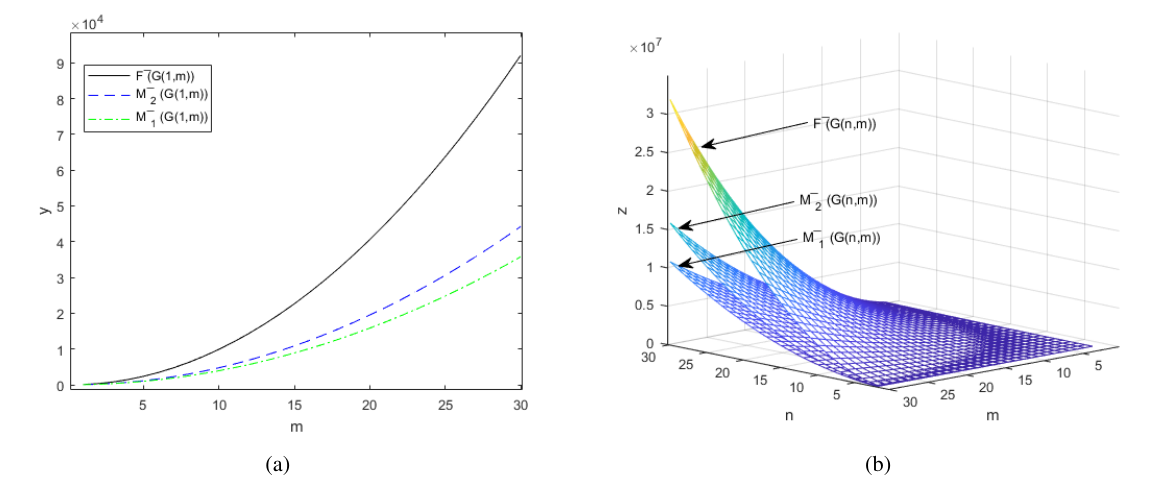
Fig. 3 Comparative model for different coindices of the graphene sheet G ( n , m ) (a) for n = 1 and (b) for n (cid:54) = 1 M = 18 ∗ ( i 2 ) ∗ ( j 2 ) + 24 ∗ j ∗ ( i 2 ) + 24 ∗ i ∗ ( j 2 ) + 8 ∗ j 2 + 8 ∗ i 2 − 32 ∗ j ∗ i − 18 ∗ j − 19 ∗ i + 24; 2